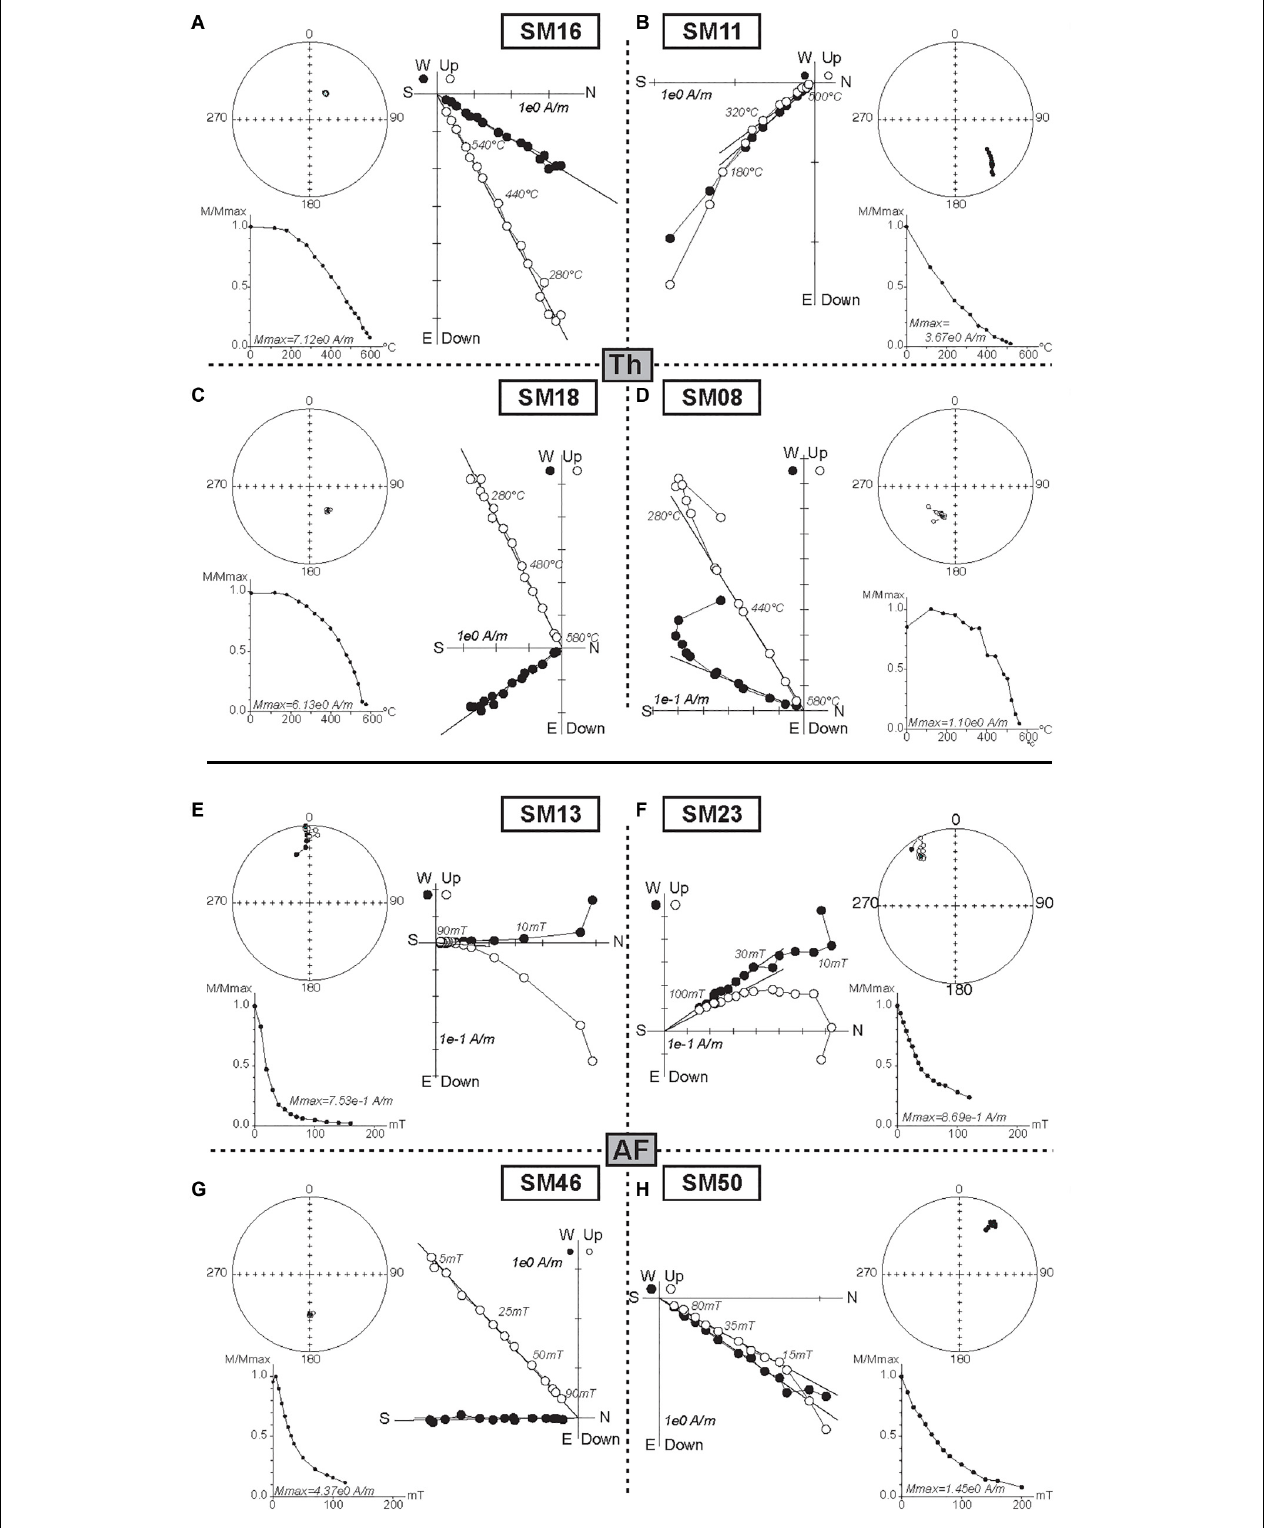
FIGURE 4 | Typical demagnetization diagrams obtained by (A–D) thermal (Th) and (E–H) alternating field (af) treatments for 8 representative samples. Solid symbols correspond to projections onto the horizontal plane, while open symbols are projections onto the vertical plane. Insets show changes in magnetization intensity (M) after each demagnetization